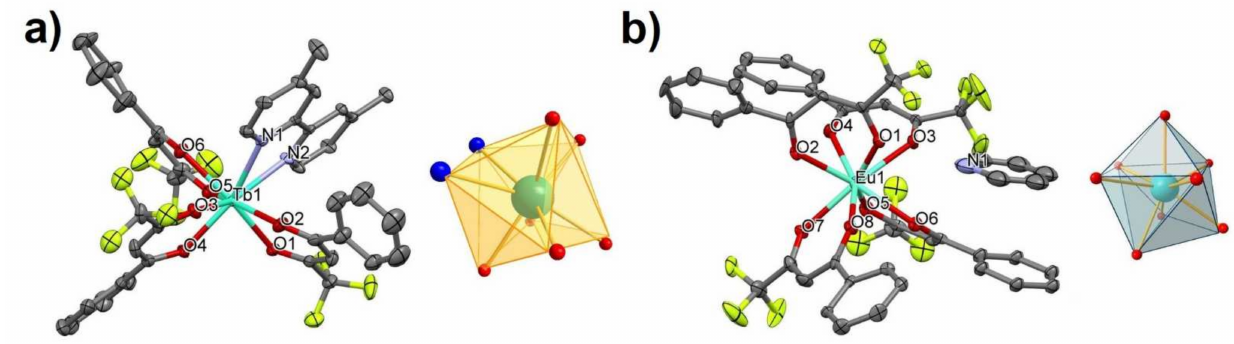
Figure 3. ( a , b ) Perspective view and coordination figure of 9 and 10 ,